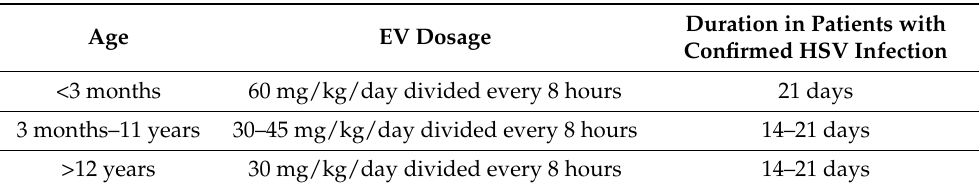
Table 2. Recommended acyclovir regimen for herpes simplex virus (HSV) central nervous system (CNS) infection in pediatric